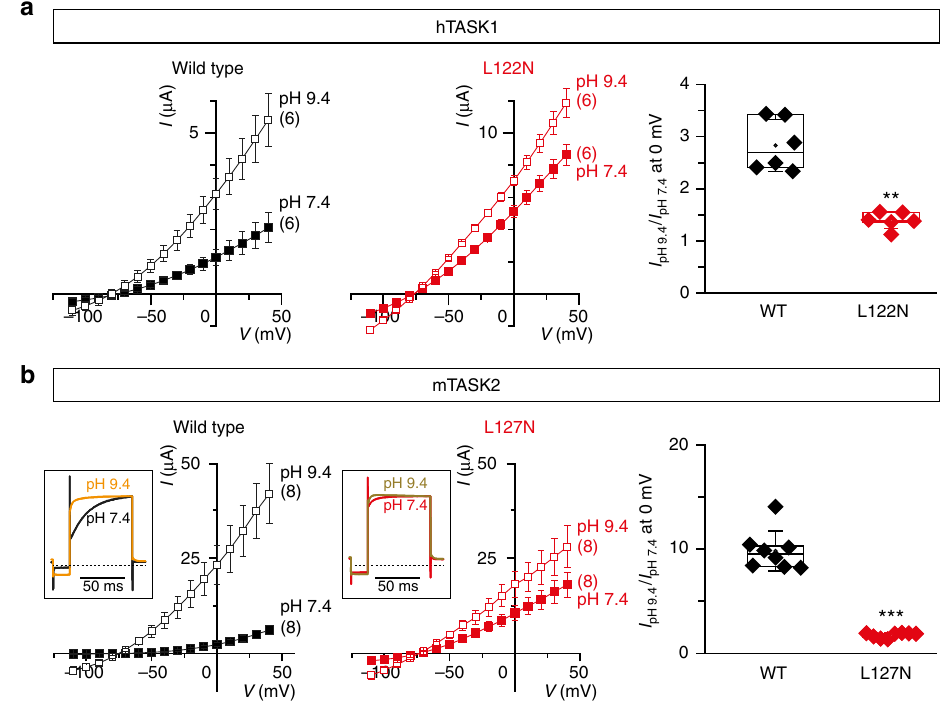
Fig. 2 TM2.6 mutation increases the basal activity of pH-sensitive K2P channels. Current – voltage relationships of a hTASK1 and b mTASK2 channels; wild- type (black) and TM2.6 mutant (red) at extracellular pH 7.4 ( fi lled squares) and pH 9.4 (open squares). Each data point represents the mean ± standard error of the mean, numbers in parentheses represent the number of oocytes tested for each condition. In ( b ), insets represent normalized current traces recorded at 0 mV. mTASK2 activation time was 91.07 ± 2.27 ms ( n = 8) at pH 7.4 (black trace) and 44.98 ± 4.96 ms ( n = 8) at pH 9.4 (orange trace). mTASK2 L127N activation time was 39.51 ± 2.25 ms ( n = 8) at pH 7.4 (red trace) and 29.41 ± 5.35 ms ( n = 5) at pH 9.4 (brown trace). Rightmost panels represent relative current increases, corresponding to the ratio between currents under pH 9.4 perfusion and currents under pH 7.4 perfusion at 0 mV. Mean relative current increases at 0 mV from pH 7.4 to 9.4 were 2.8 ± 0.2 and 1.4 ± 0.1 for wild-type and mutant hTASK1, respectively. Mean relative current increases were 9.8 ± 0.7 and 1.8 ± 0.1 for wild-type and mutant mTASK2, respectively. Currents were recorded 24 h after injection of cRNA (mTASK2 and mTASK2 L127N, 5 ng/oocyte; hTASK1, 2.28 ng/oocyte; hTASK1 L122N, 0.38 ng/oocyte). Each data point represents one oocyte; center lines, medians; open circles, means; box limits, 25th and 75th percentiles; whiskers, standard deviation. Mann – Whitney, ** p < 0.01, *** p <